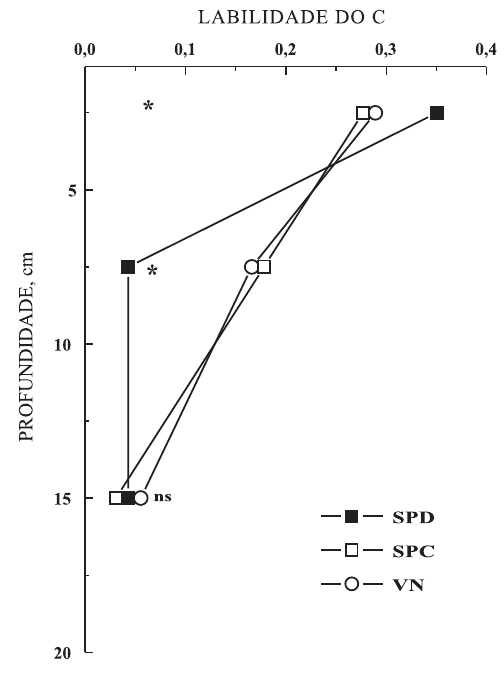
Figura 1. Labilidade do carbono orgânico (razão C particulado/C associado aos minerais) em Gleissolo Háplico sob vegetação natural (VN), sistema de preparo convencional (SPC) e sistema plantio direto (SPD). *: médias dos tratamentos SPC e SPD, em cada profundidade de solo, diferem entre si pelo teste de Tukey a 5 %; ns: diferença não significativa; resultados da VN não foram submetidos à análise de